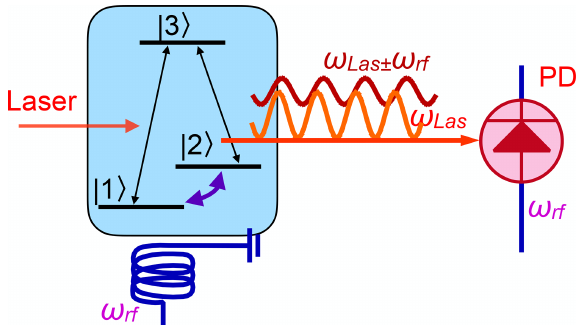
Figure 9. Basic principle of coherent Raman